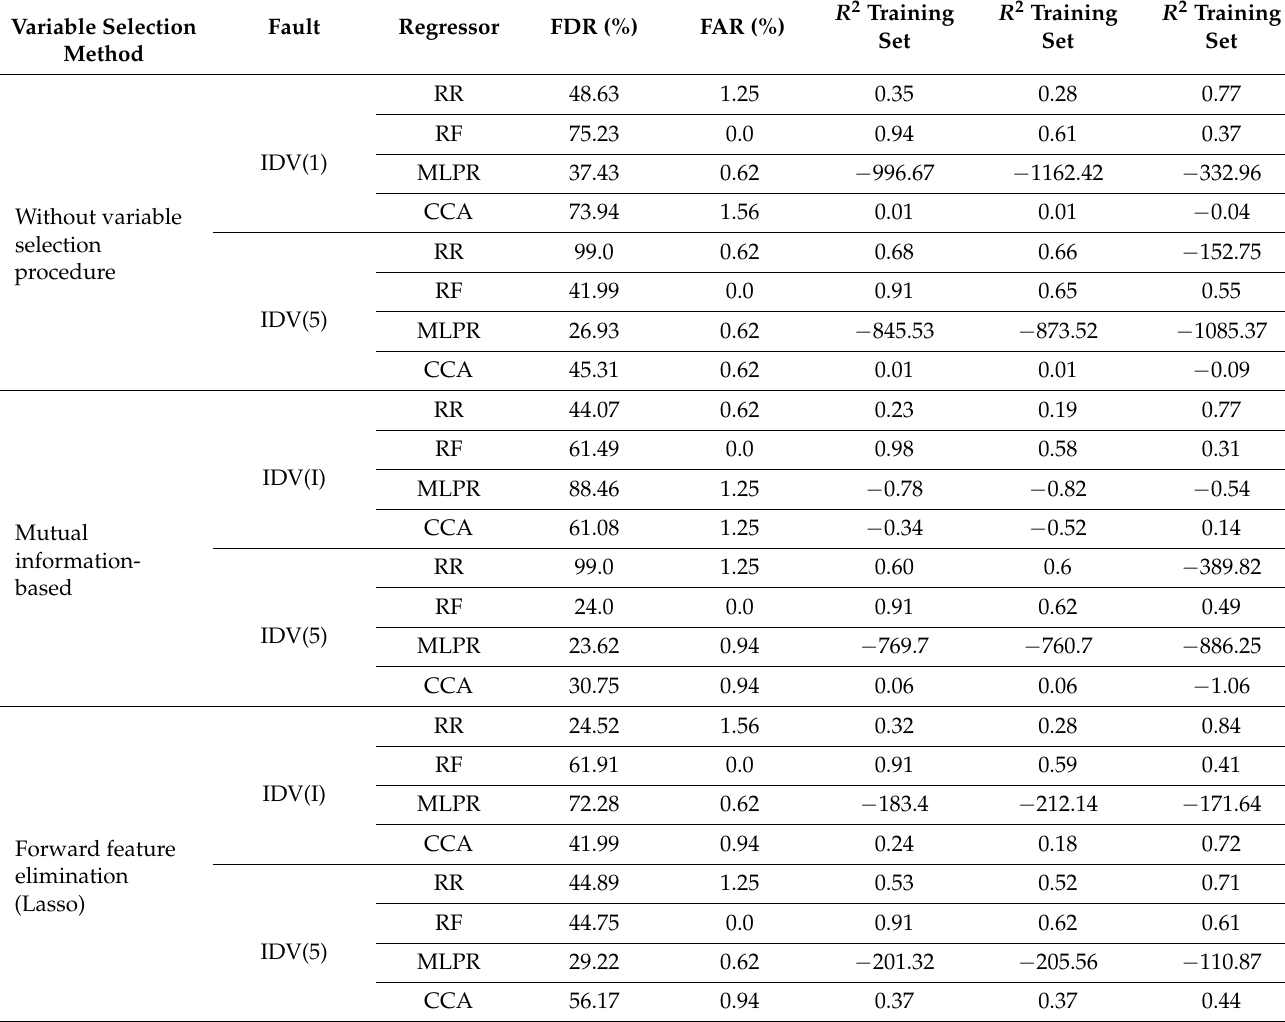
Table 11. Performance of the variable selection procedures used to analyze the TEP